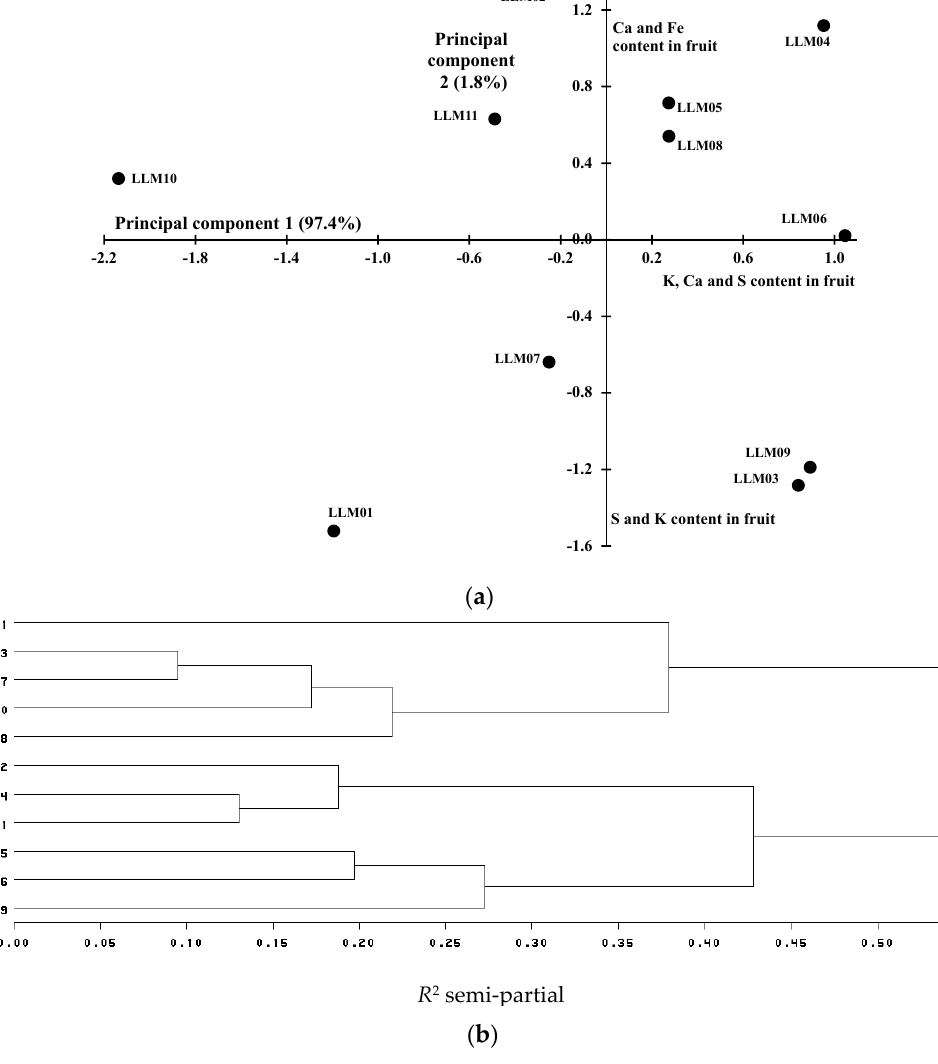
Figure 2. Dispersion of tomato accessions from El Salvador, based on two first principal components ( a ) with variables associated to higher eigenvector values, and ( b ) with hierarchical clustering by Ward’s method, regarding mineral content in tomato fruits.